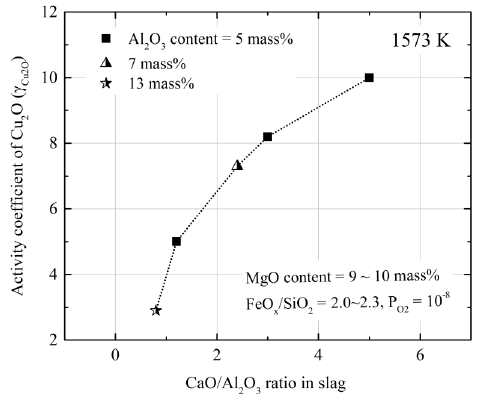
Figure 3. Effect of the CaO/Al 2 O 3 ratio on the activity coefficient of Cu 2 O in the slag at 1573 K. The content of MgO is 9–10 mass%, the ratio of FeO X /SiO 2 is 2 to 2.3, and the oxygen partial pressure is 10 − 8